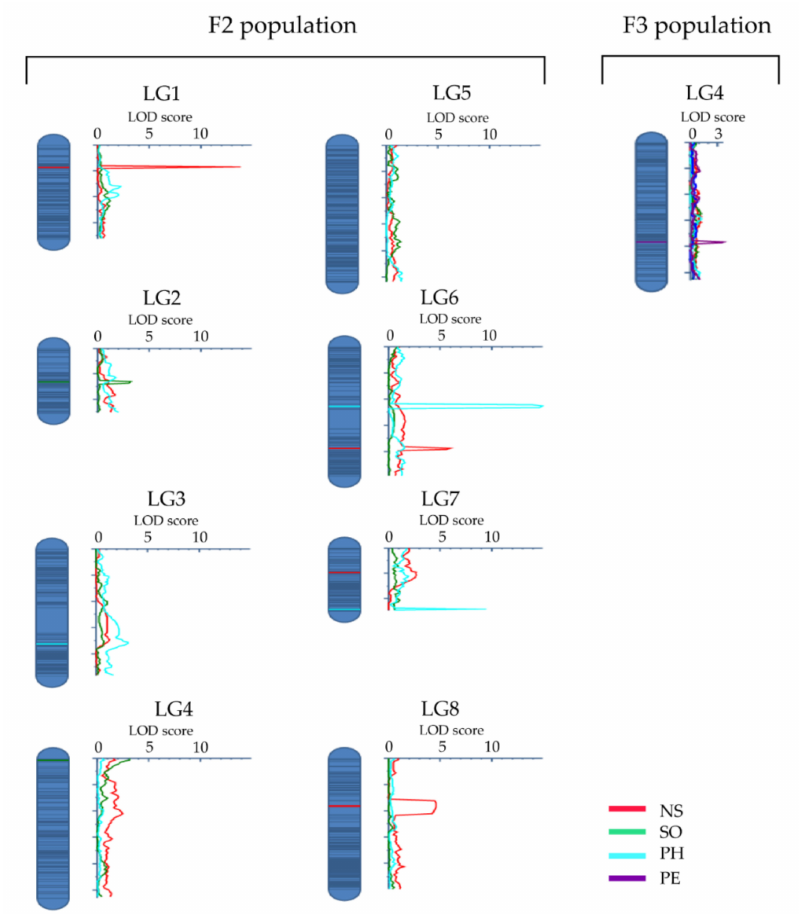
Figure 2. The distribution of the nine QTLs identified in this study across the field cress linkage groups for four characteristics: number of stems per plant (NS, red), stem growth orientation (SO, green), plant height (PH, turquoise), and perenniality (PE, purple). The QTLs are identified based on the F 2 population data, except the QTL for PE on LG4, which was identified based on the F 3 population data. The x -axis shows logarithm of the odds (LOD) score